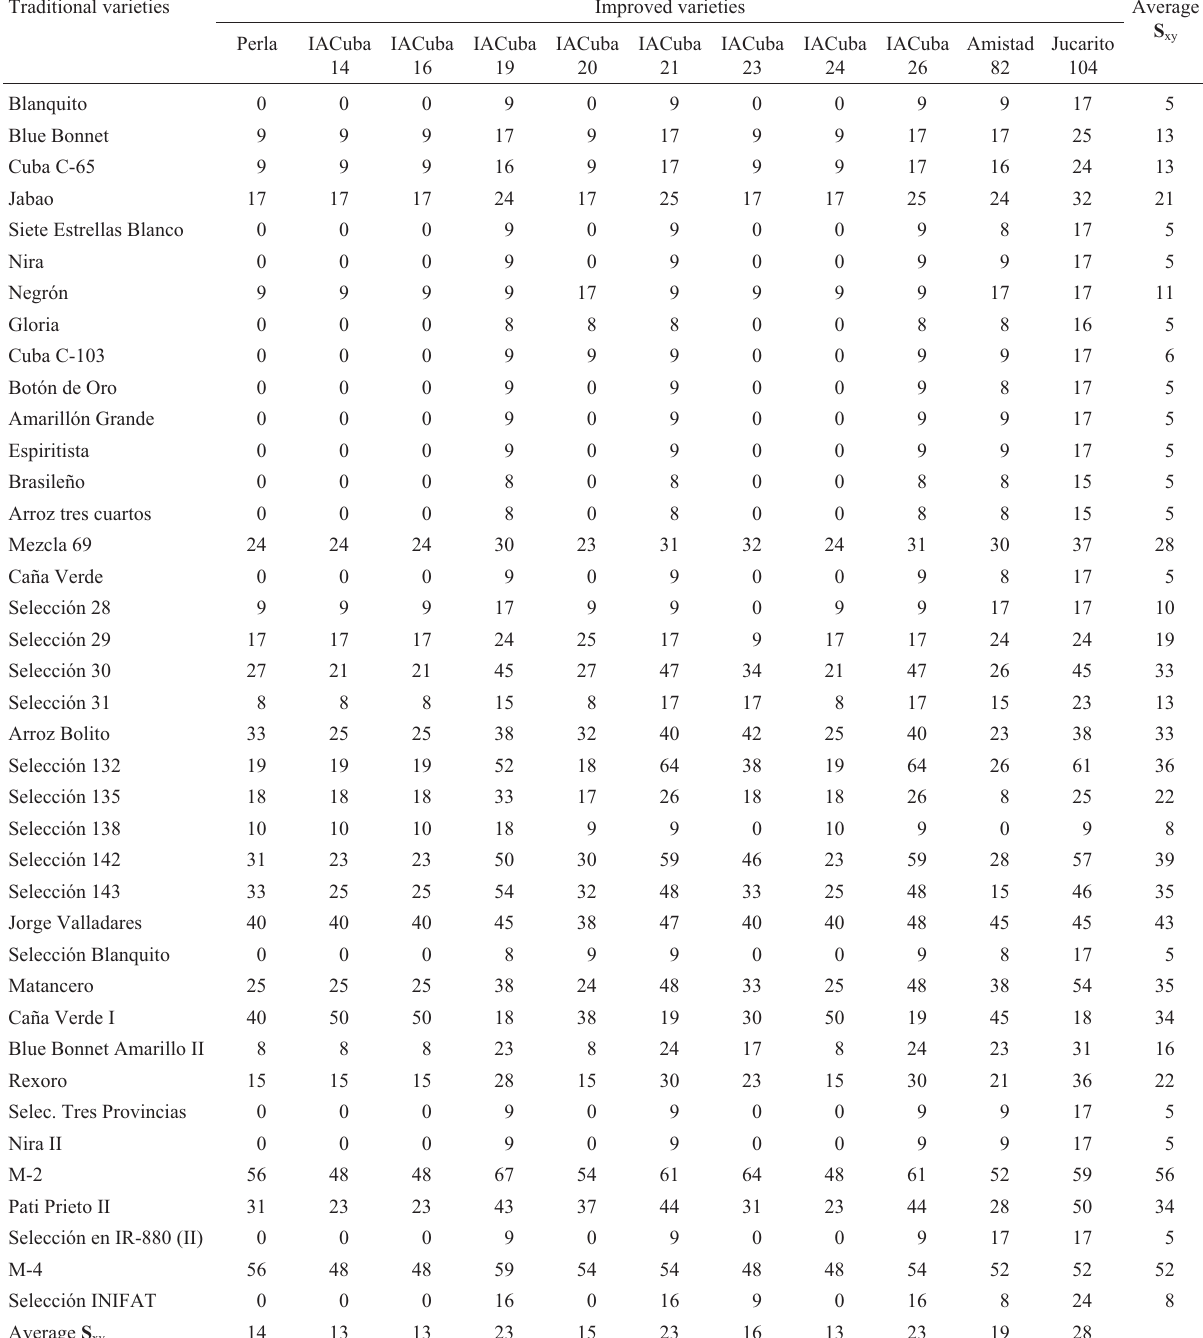
Table 4 - Proportion of shared alleles ( S xy ) between traditional and improved varieties pairs expressed in percentage. Average values for each traditional and improved variety is given in the last column and row, respectively. Traditional